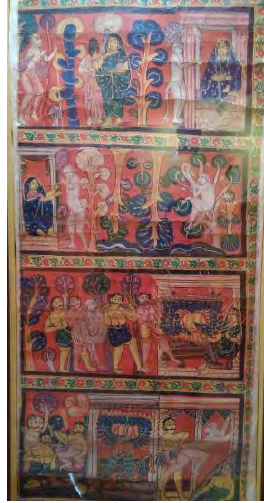
Figure 1 Ramayana Pata West Bengal, 20 th Century, Cloth National Museum, New